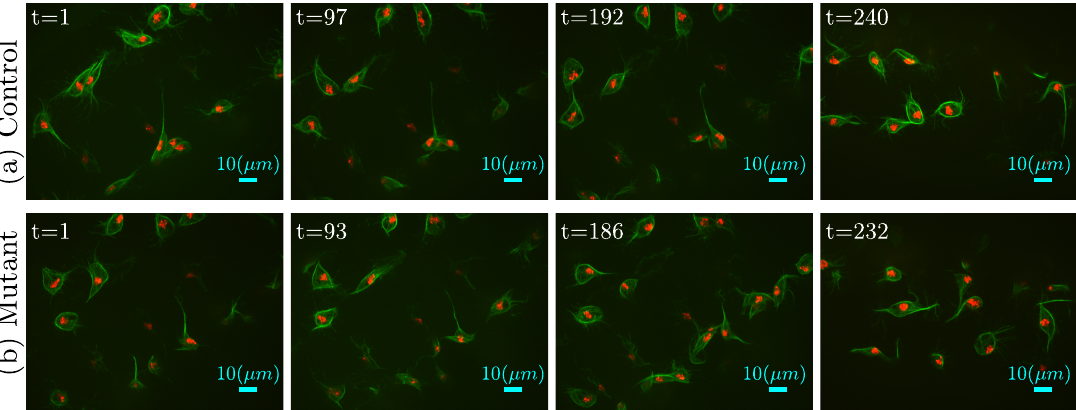
Figure 2. Comparison between four frames of ( a ) the control against four frames of a ( b ) mutant dataset. These datasets were selected as they had a similar number of frames, and thus, a similar spacing between the frames in both cases could be shown ( ≈ 95).